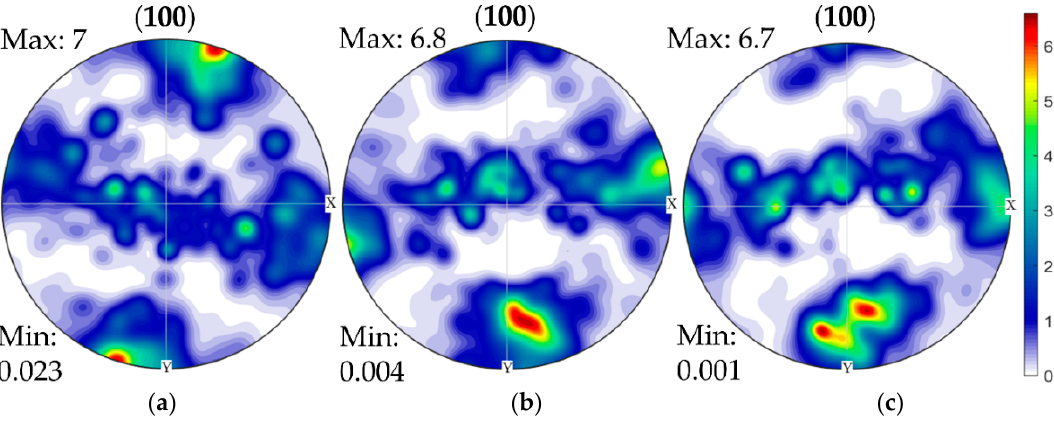
Figure 11. Pole figures for clad layers: ( a ) clad I, ( b ) clad II bottom layer, and ( c ) clad II upper layer.